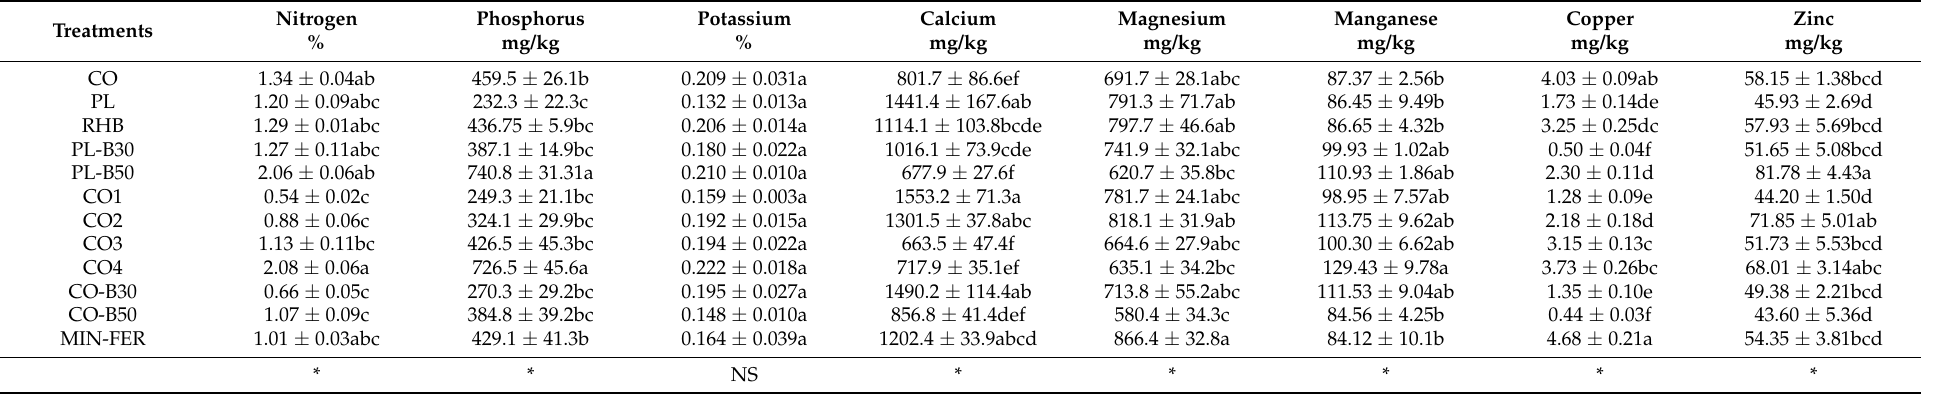
Table 5. Plant nutrients concentrations at 50 days after harvest.